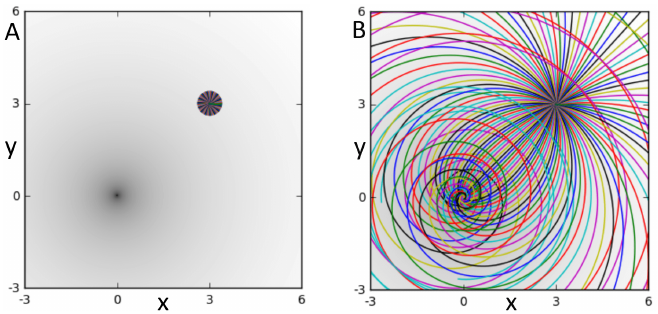
Figure 9: Null geodesic trajectories for the isotropic power-law model with α = 1. A: Geodesics released at ( 3,3 ) with various launch angles, φ